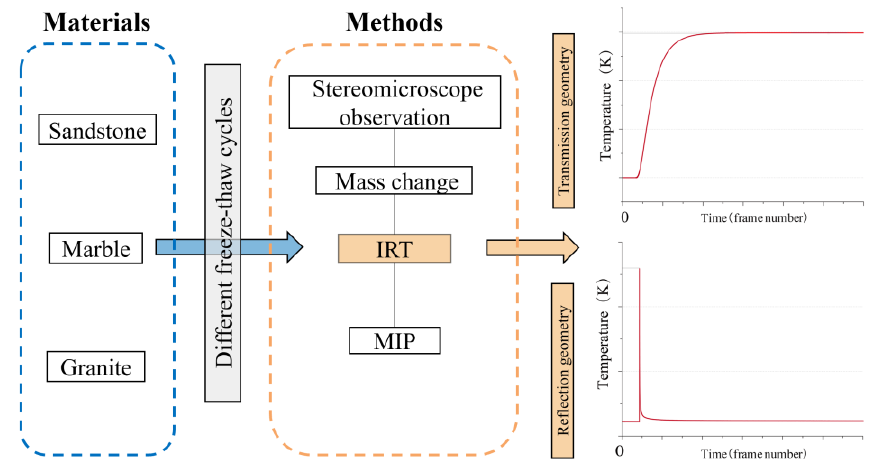
Figure 1. Illustration of the research process.